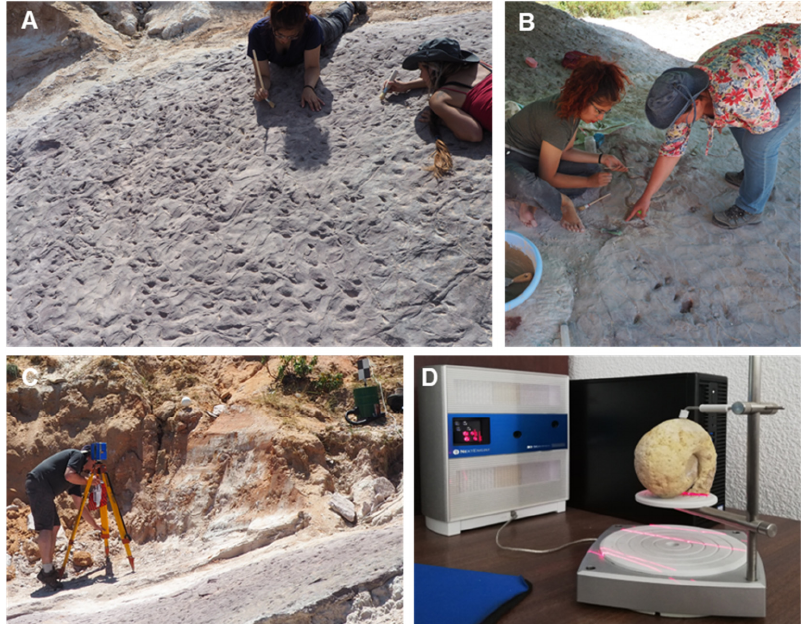
Figure 2. Onsite and virtual palaeontology methodologies. ( A ) Cleaning of the track surface by means of traditional tools to enable correct taking of photographs and scanning of the tracksite. ( B ) Systematic on-site study of the main tracks, applying traditional methods such as drawings. ( C ) Phase-shift scanning of the track surface with the “Laser Scanner Focus 3D”. ( D ) Laser triangula- tion scanning by using a small object scanner “NextEngine 3D Laser Scan” for the virtualization of Geosciences 2023 , 13 , 16 invertebrate fossil samples.